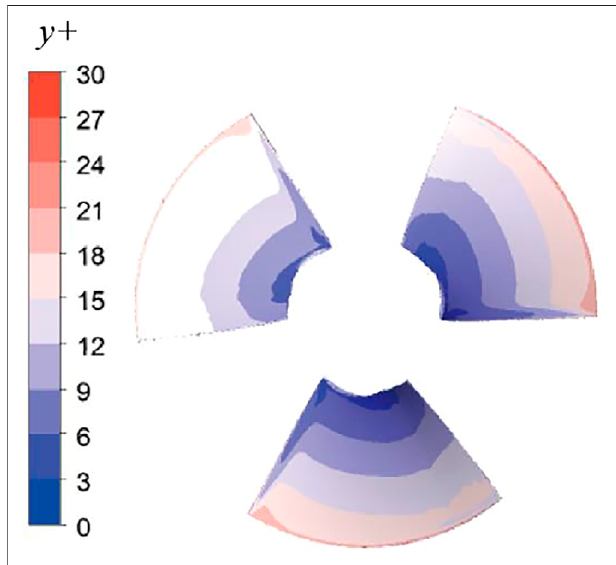
FIGURE 2 | Distribution of y + on the blade